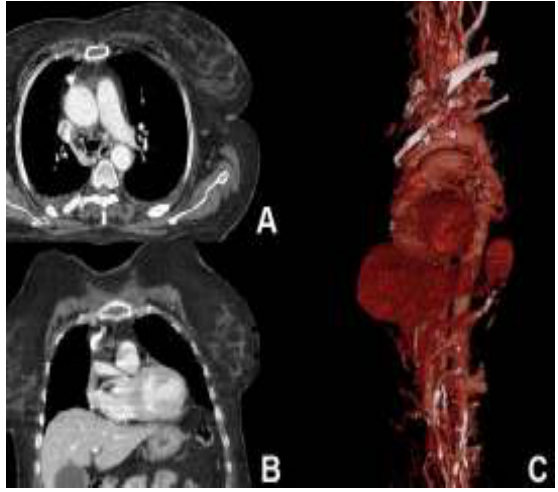
Figure 2. Computed tomography venography; axial plane showing tip of catheter outside the superior vena cava and surrounding hematoma being evident (A); coronal plane also illustrating the extraluminal position (B); reconstruction of contrast material also demonstrating catheter position